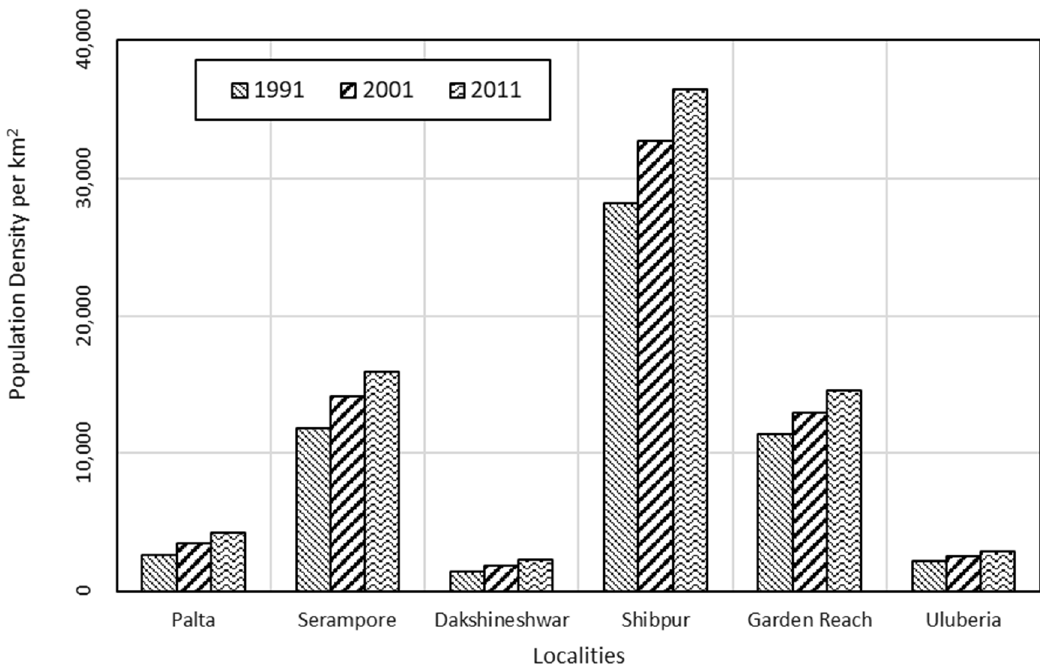
Figure 6. Bar chart for population density (Census data [44]).